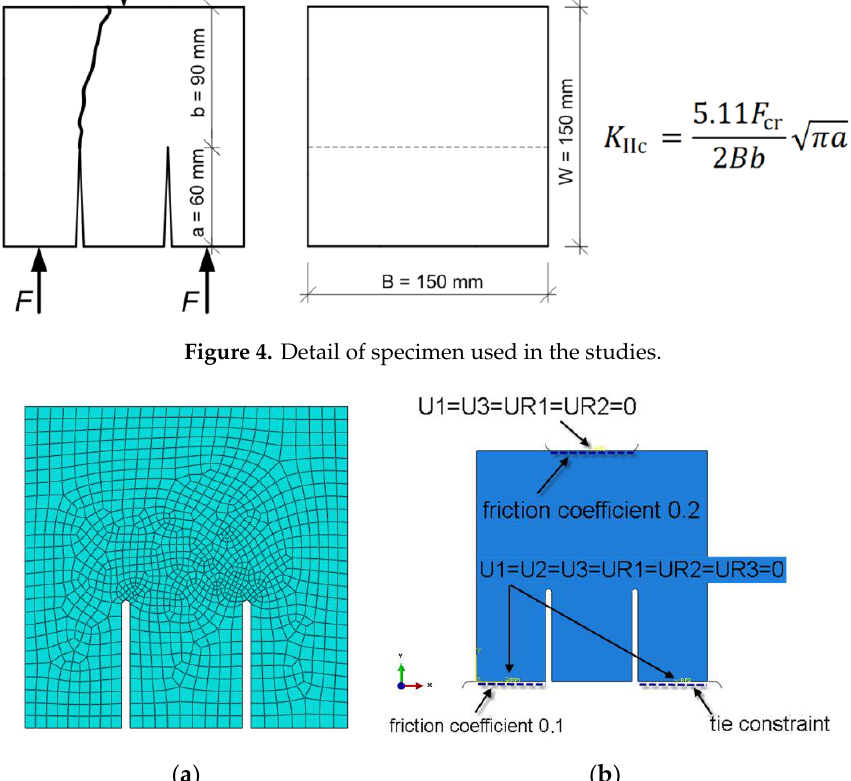
Figure 5. Specimen used in numerical analyses with ( a ) finite element mesh ( b ) boundary conditions: U—displacement, UR—rotation.